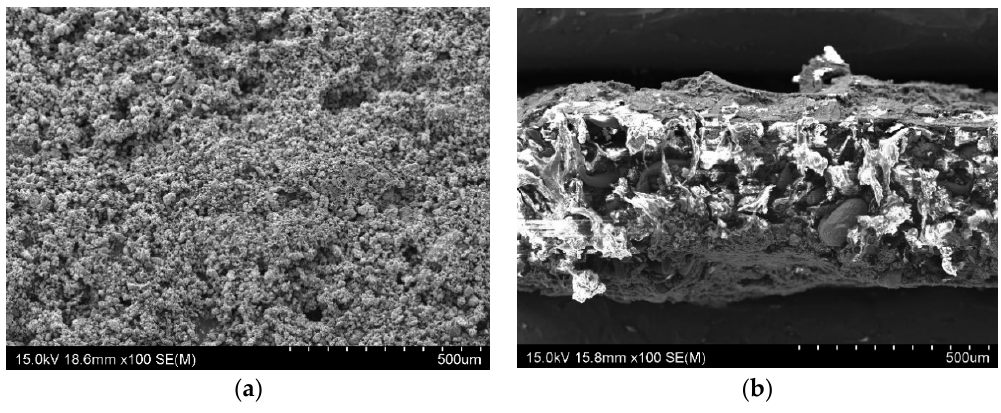
Figure 3. SEM image of the proposed gas diffusion material. ( a ) Surface; ( b ) Cross-section.